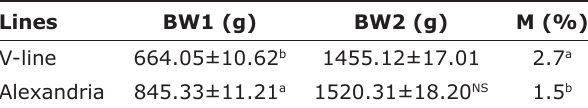
Table-3: Means and standard errors of individual body weight at weaning (28 days), individual body weight at market (63 days) and mortality rate (%) of V-line and Alexandria